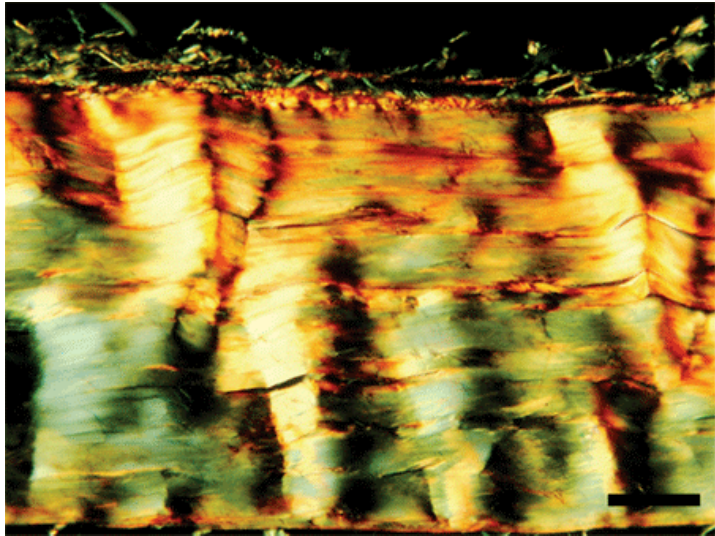
FIGURE 9. Polarized light micrograph of longitudinally sectioned rat Achilles tendon. Collagen fiber bundles show a crimping pattern characterized by alternating periodic dark and light bands. These structures correspond to the tendon crimps. Bar = 100 μ